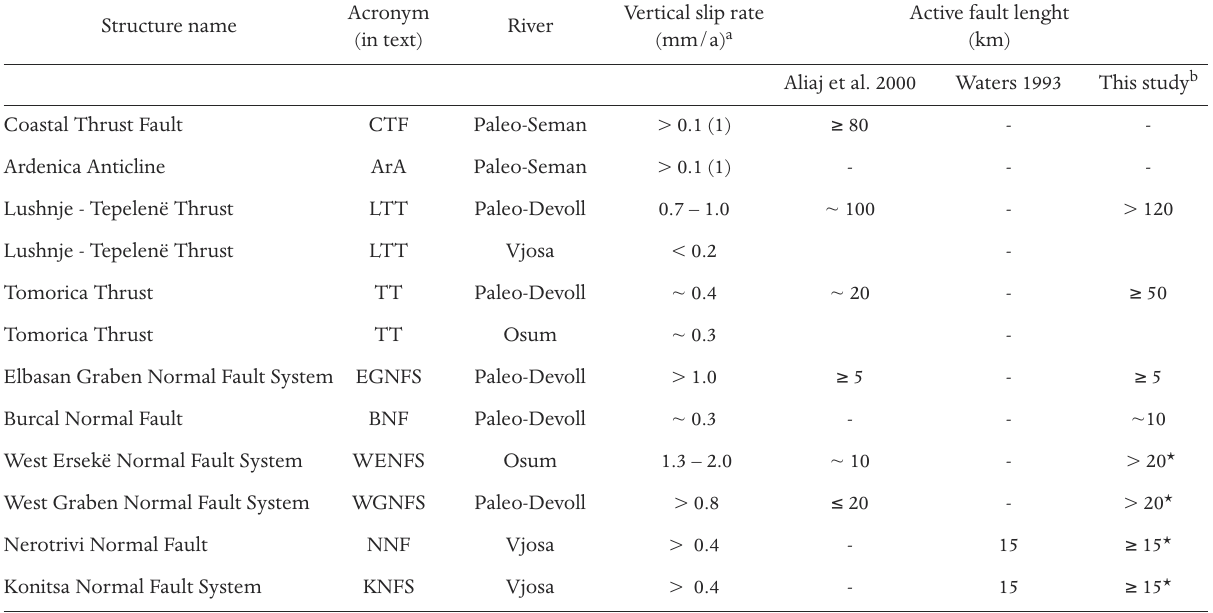
Table 2. Vertical slip rate of active structures in Albania, analyzed from the incision of river terraces of Paleo-Devoll, Osum and Vjosa